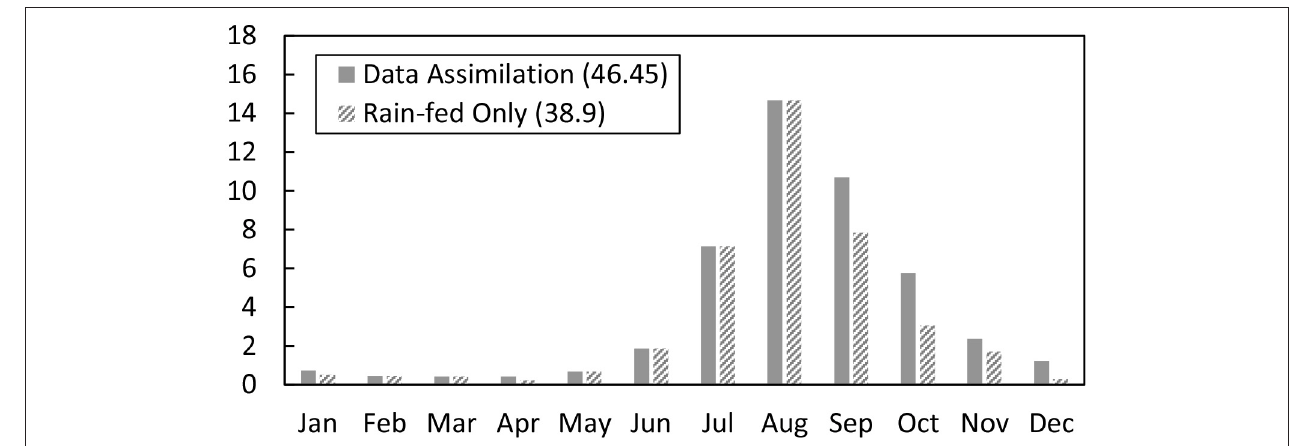
FIGURE 5 | A comparison between the long-term average basin runoff and the resulting runoff after allocating water and land resources to rain-fed agriculture.